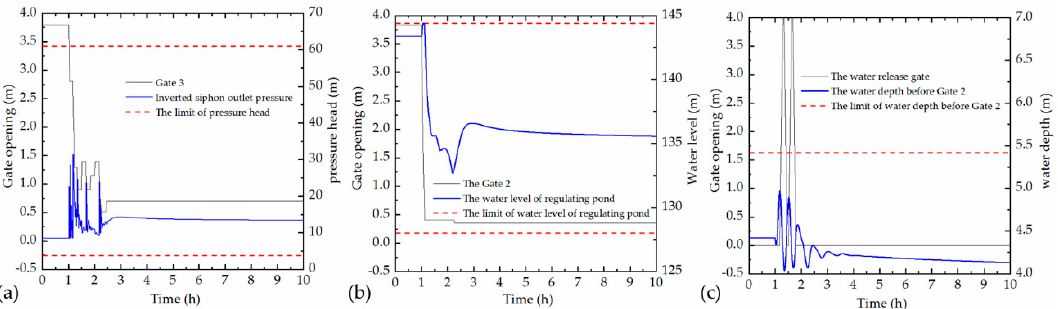
Figure 7. The simulation result of Scenario B with target flow of 20 m 3 / s: ( a – c ) are same with Figure 6.